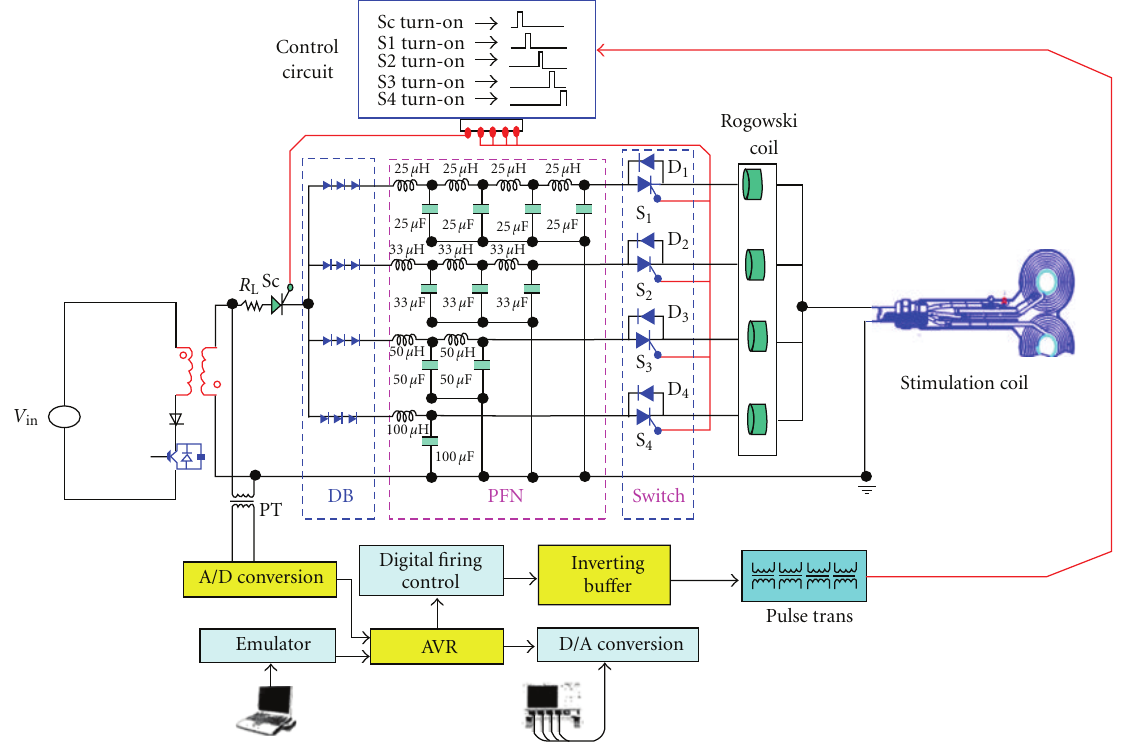
Figure 1: Diagram of the proposed magnetic stimulation